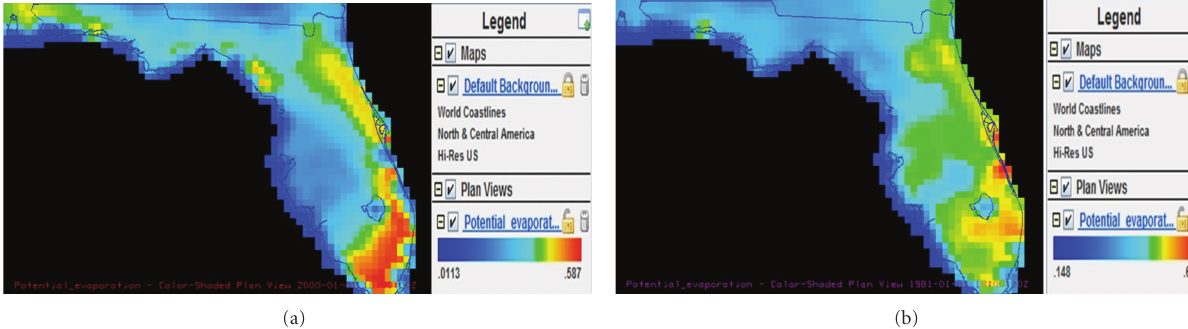
Figure 11: (a) Potential evaporation calculated from NLDAS at January 1, 2000, 18 PM. (b) Potential evaporation calculated from NLDAS at January 1, 1981, 18